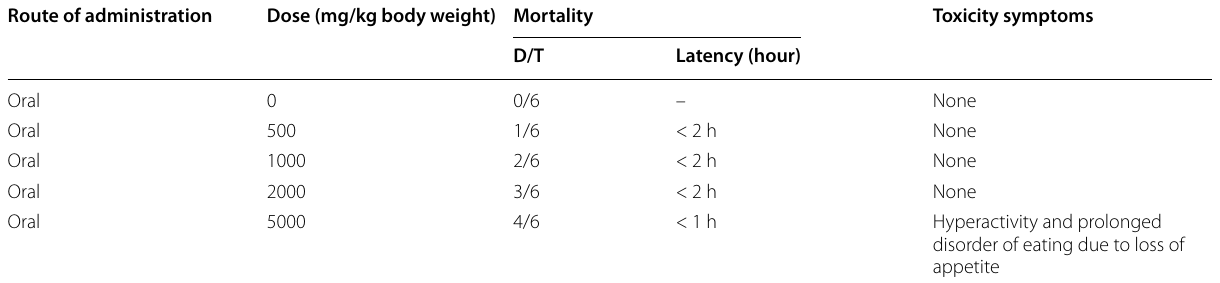
Table 2 Mortality and clinical signs of acute toxicity of Q3G-RF from S. mombin leaves administered orally to rats Route of